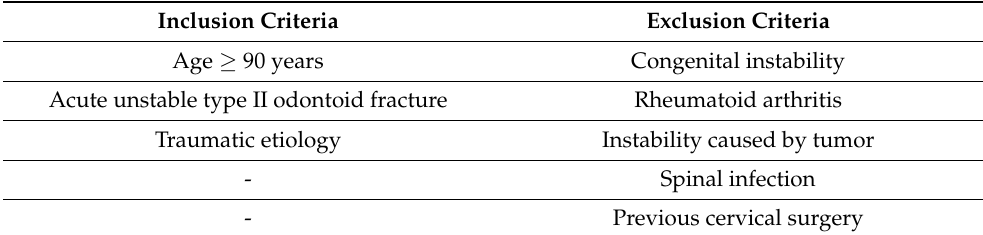
Table 1. Inclusion/Exclusion